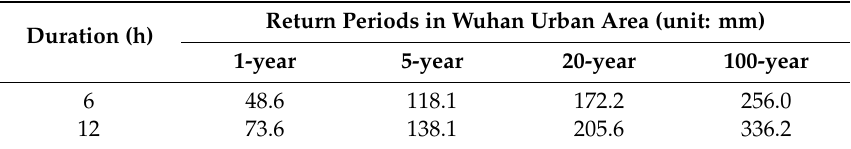
Table 4. The short-duration rainfall in the urban area of Wuhan (unit: mm) [41].